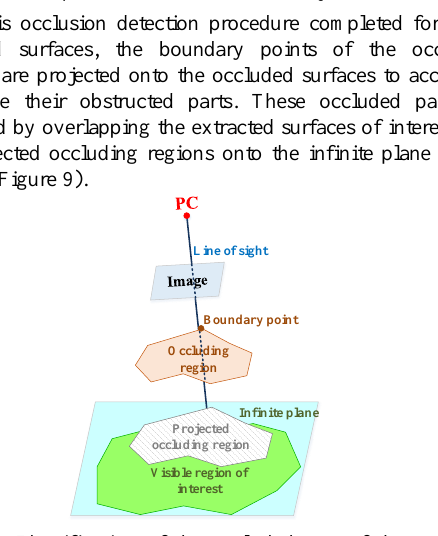
Figure 9. Identification of the occluded part of the region of interest